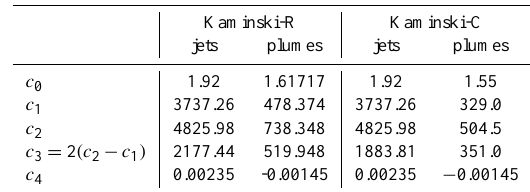
Figure 2. Entrainment functions A(z s ) for jets and plumes depend- ing on the dimensionless height z s = z/ 2 r o . Functions have been obtained by fitting experimental data (points) from Carazzo et al. (2006) (for z s > 10) and multiplying by a correction function (20c) to extend the functions to z s < 10 verifying function continuity and convergence to values of A = 1 . 11 for jets and A = 1 . 31 for plumes when z s → 0. Table 3. Constants defining the entrainment functions for jets and plumes following the formulation introduced by Kaminski et al. (2005) (see Eq. 20a to 20c) obtained after fitting experimental data reported in Carazzo et al. (2006). For Kaminski-R we considered all data including that of Rouse et al. (1952), whereas for Kaminski-C, as suggested by Carazzo et al. (2006), data from Rouse et al. (1952) was